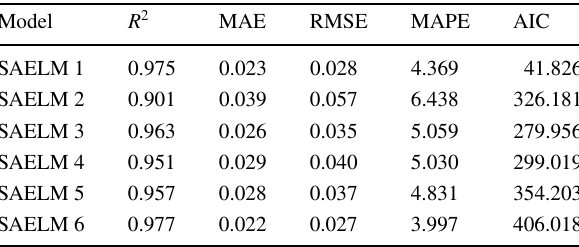
Table 2 Results of different statistical indices of SAELM models Model